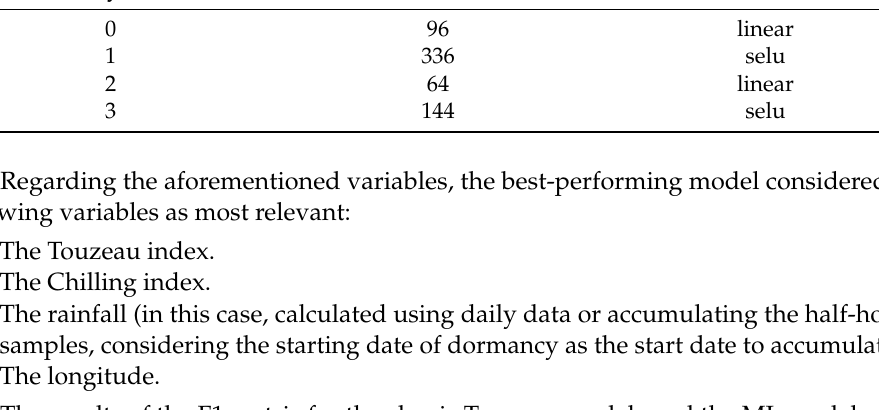
Table 1. Description of the best-performing artificial neural network (ANN). Layer